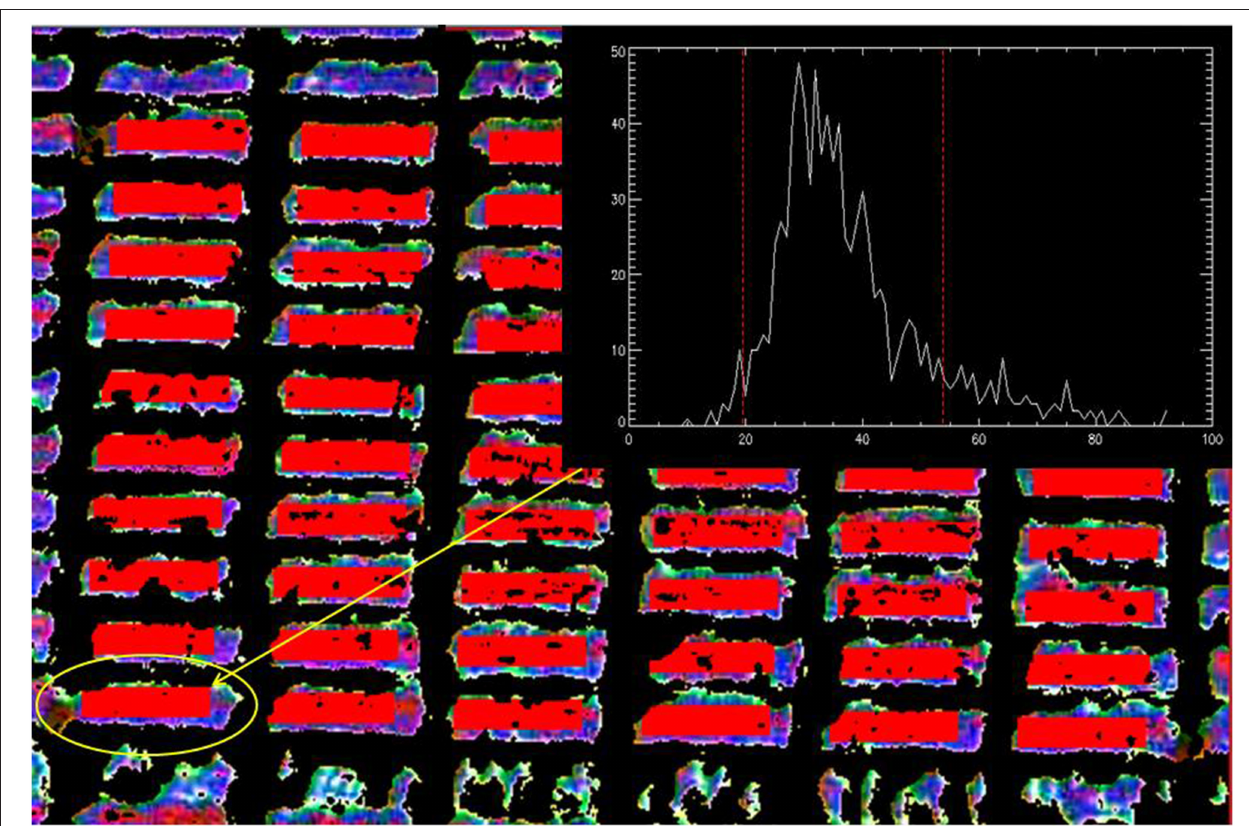
FIGURE 3 | Example of the image processing using UAV-mounted FLIR Tau image of “HOT” trial shown in Figure 2B where a mask is applied to remove any non-vegetation pixels by applying a threshold for each pixel value. This is followed by the detection of each plot using pre-defined location parameters (red rectangles) and the removal of high variance pixels (using histogram of the pixel values of each plot). An average of pixel values over each band is taken to get a value per band per plot. This value is then subsequently used to calculate the target